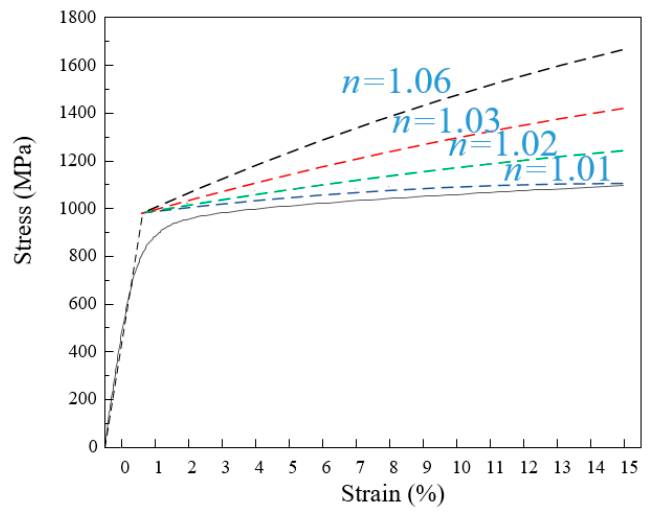
Figure 4. Comparison of stress–strain curves.